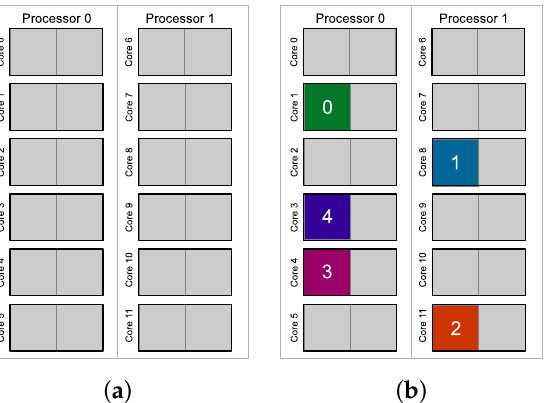
Figure 11. Thread placement when no affinity is used. ( a ) Platform’s architecture. ( b ) Example of thread placement without control